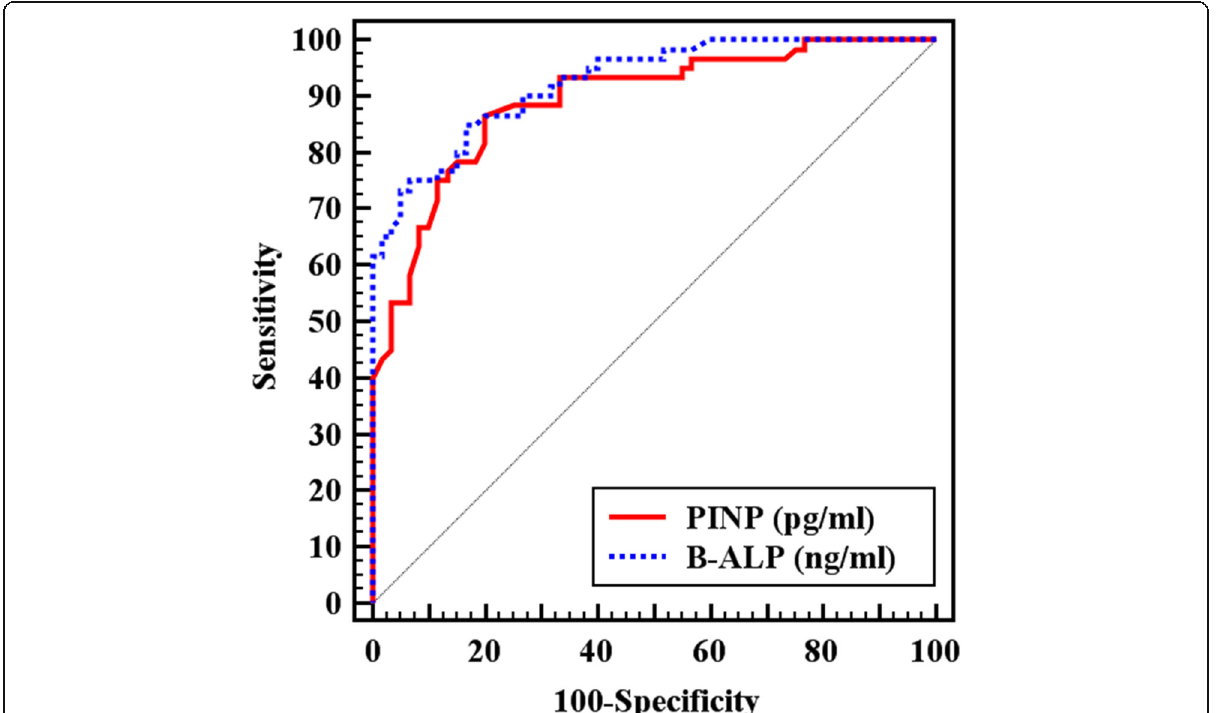
Fig. 2 ROC curve for PINP and B-ALP to discriminate osteoporosis patients from healthy control